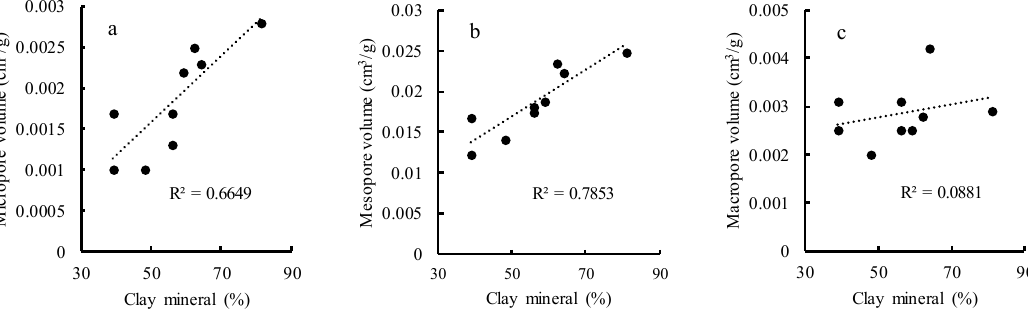
Figure 4. ( a ) The relationship between micropore volume and clay mineral content. ( b ) The relationship between mesopore volume and clay mineral content. ( c ) The relationship between macropore volume and clay mineral content.